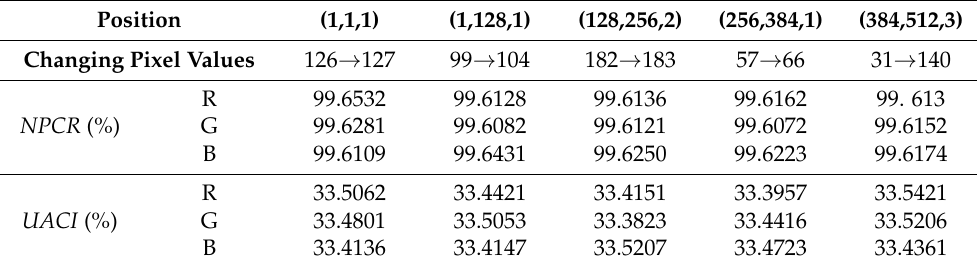
Table 5. Results of NPCR , UACI and BACI at different locations in the Peppers image. Position Changing Pixel